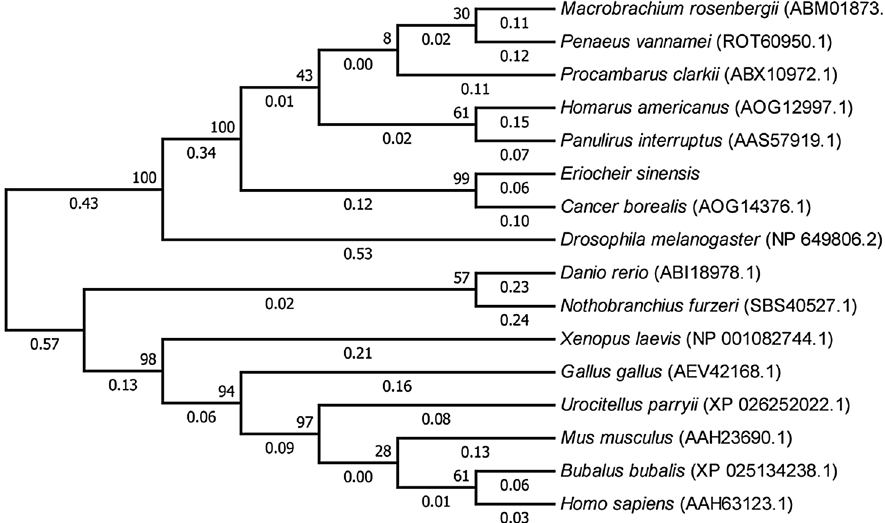
Figure 3. Phylogenetic relationship of the 5-HT2B gene between E. sinensis and other invertebrates and vertebrates. Bootstrap values from 1000 replicates are indicated at the nodes.